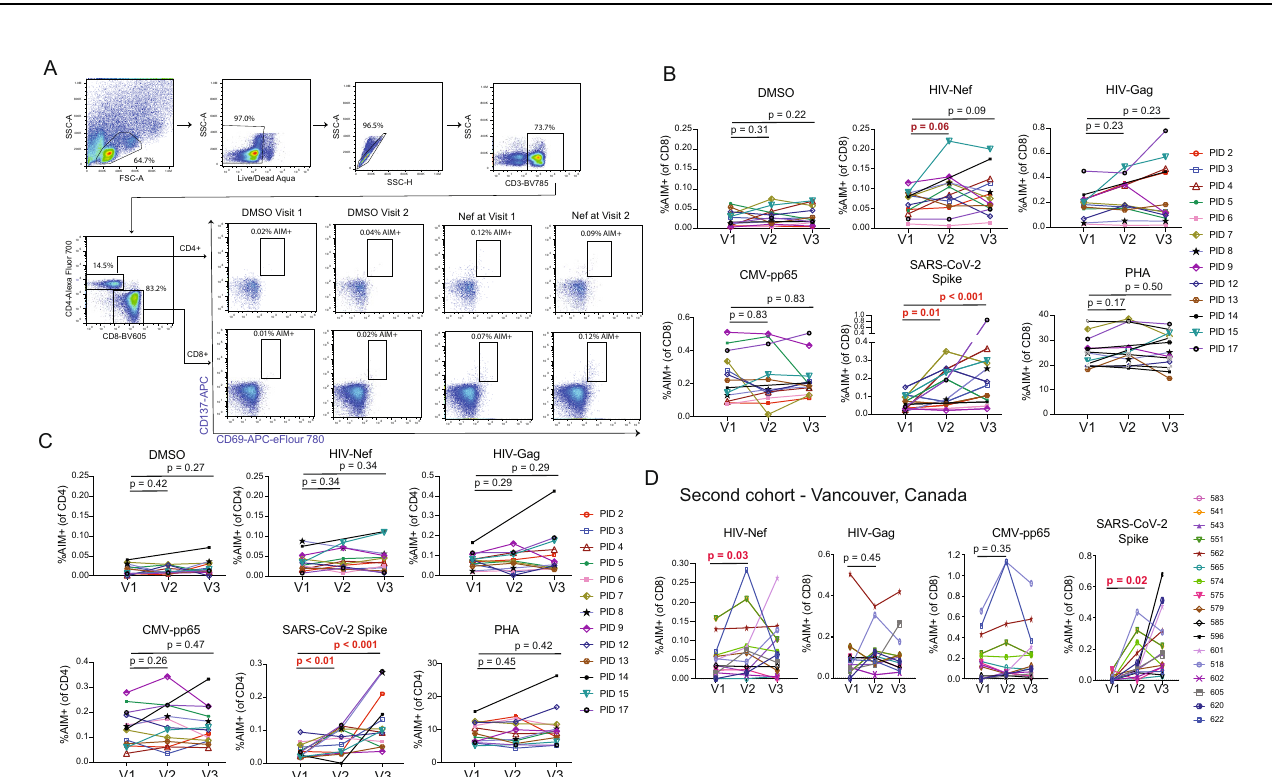
Fig.2|Timelinesforthethreeclinicalcohortsincludedinthisstudy. Shownareblooddrawdates(V1,V2,andV3)alongsidetimingsofSARS-CoV-2mRNAvaccinations (Dose 1, Dose 2, and Dose 3).